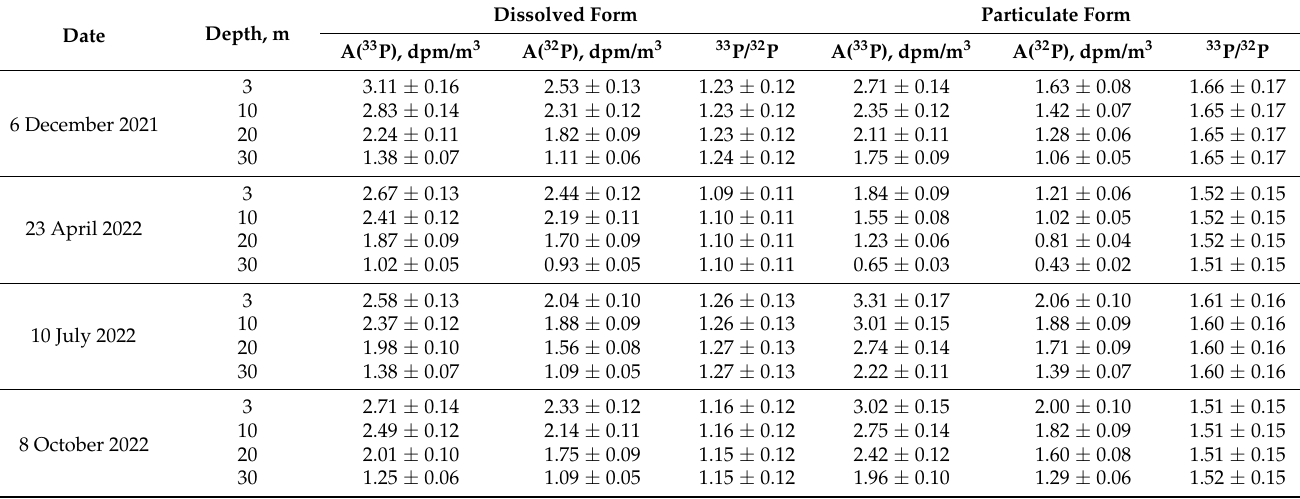
Table 2. Values of 32 P and 33 P activity and the ratio 33 P/ 32 P in different